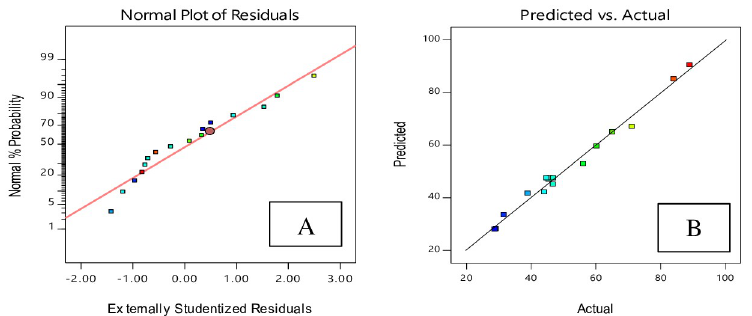
Fig 14. Residual plots for particle size of HAp nano powder, according to CCD. A: Normal probability; B: residuals versus predicted.